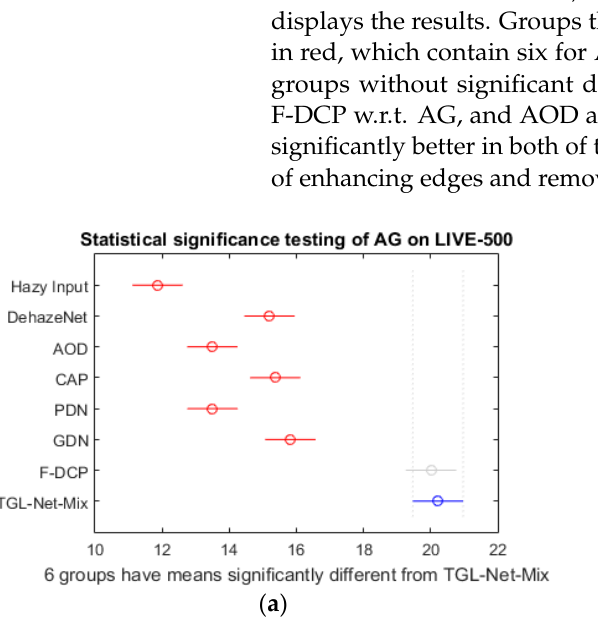
Table 5. Average values of non-reference measures on LIVE and Internet datasets.